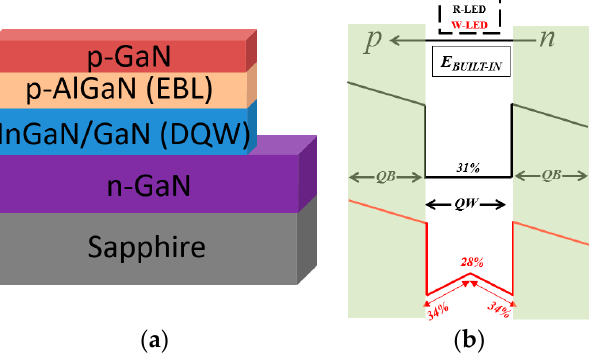
Figure 1. Schematic of the ( a ) device; ( b ) R-LED and W-LED indium composition in the quantum well.